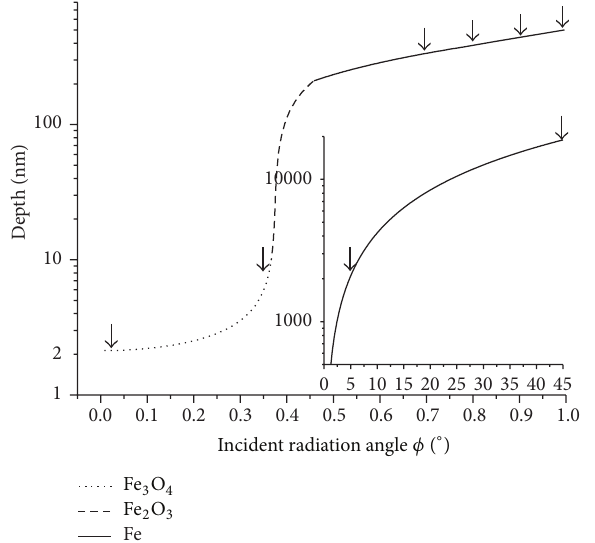
Figure 3: Calculated penetration depth (3) as a function of the incident radiation angle for sample B. Incident radiation energy 7072 eV. Irradiation angles are also plotted.